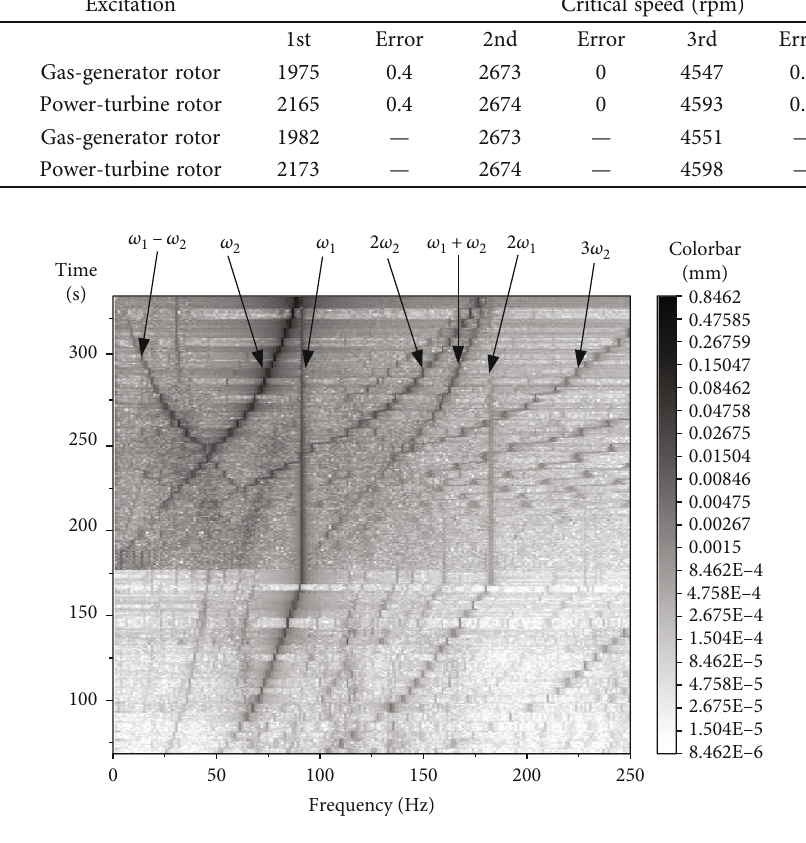
Figure 10: Test results: measuring points for power turbine (PT) rotor.